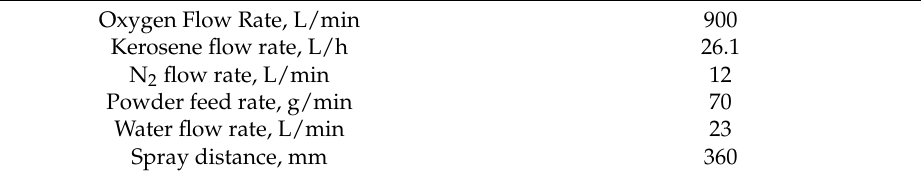
Figure 1. The schematic diagram of the HVOF coating manufacturing process. Table 1. Spraying parameters of cermet coatings.